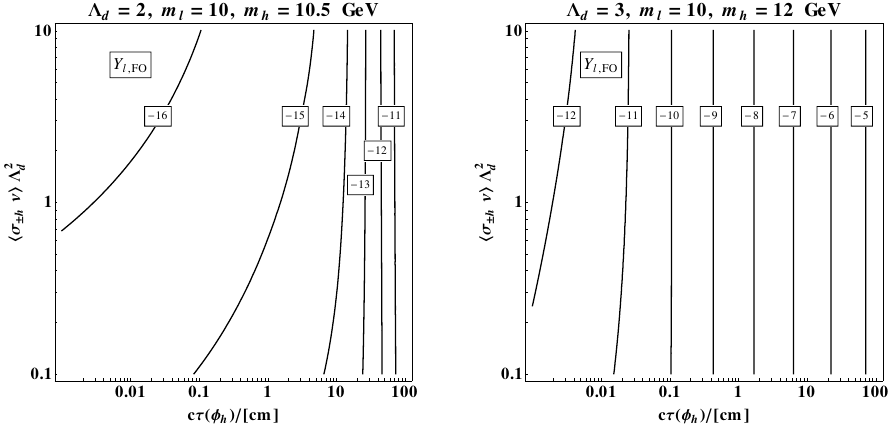
2 assumptions. For the lifetime bound we are d (cid:27) (cid:6) h v (cid:3) 2 . d h i